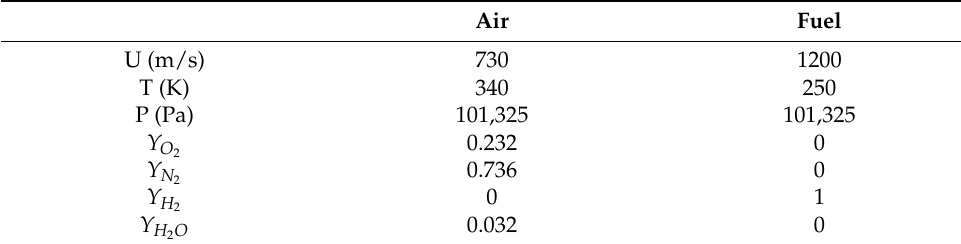
Figure 14. Computational set up of the DLR supersonic combustion case. Table 1. Flow conditions of the airstream and the fuel inlet.